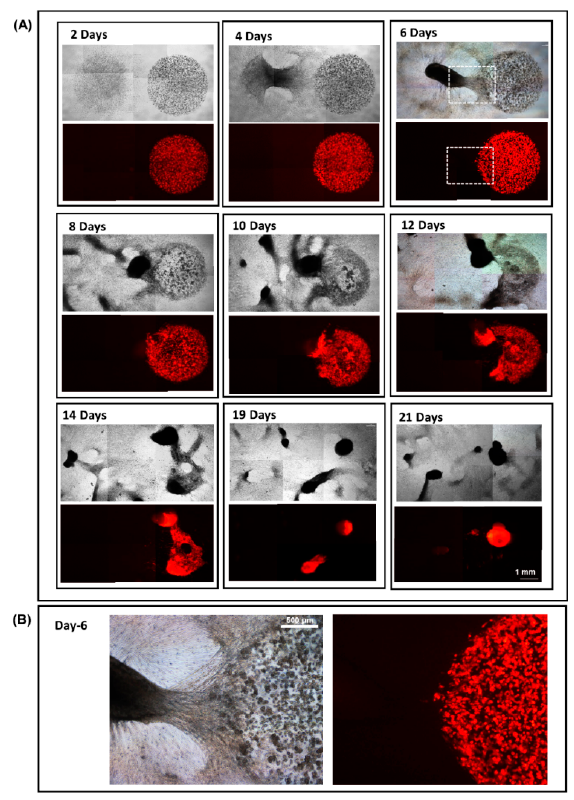
Figure 6. A 3D dumbbell model designed to study fibroblast-guided cancer cell migration. ( A ) Fibroblast and CaKi-1 cells were seeded as independent droplets separated by a 1 mm Matrigel causeway. Upon forming a meshwork of vessel-like structures, fibroblast cells swiftly migrated across the causeway to infiltrate and eventually encapsulate the entire CaKi-1 cell population within a spheroid. ( B ) Enlarged view of the fibroblast invasion front on day 6. Note that the cancer cells are pre-labelled with RFP. Incubation for a further two to four days allowed the vast majority of the fibroblasts to reach the end of the causeway and into the cancer cells’ territory (Figure 6A: day 8 to 10). Due to their inherent affinity for the fibroblast vessel-like structures, the cancer colonies progressively succumbed to infiltration and engulfment by the fibroblast cells until their eventual encapsulation inside a dense spheroid, as shown by the sequence of images taken from day 12 to 21. Throughout the 3 weeks incubation period, we had been able to observe and monitor the entire process of cancer cell encapsulation, from the initial formation of a fibroblast vessel-like network to eventual entrapment of the CaKi-1 colonies using the dumbbell model described herein.